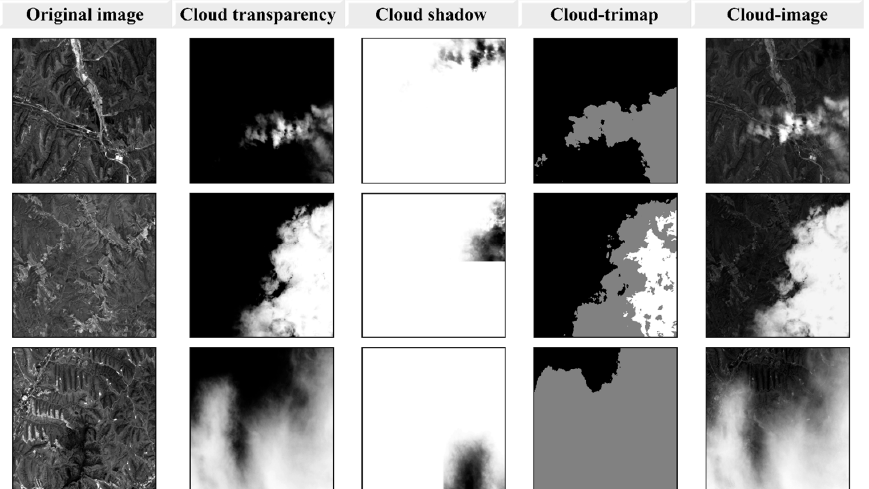
Figure 3. Cloud-matting dataset generation. Columns 1–3: The cloud-free image base map with Sentinel-2 Band2. The cloud transparency information notation is α . The cloud shadow notation is f ( 1 − α ) , which is randomly generated according to cloud transparency, and f represents the offset calculation. The fourth column is the trimap image of the cloud, and we set α > 0.9 relative to the cloud-trimap foreground. The fifth column is the composite image with clouds.